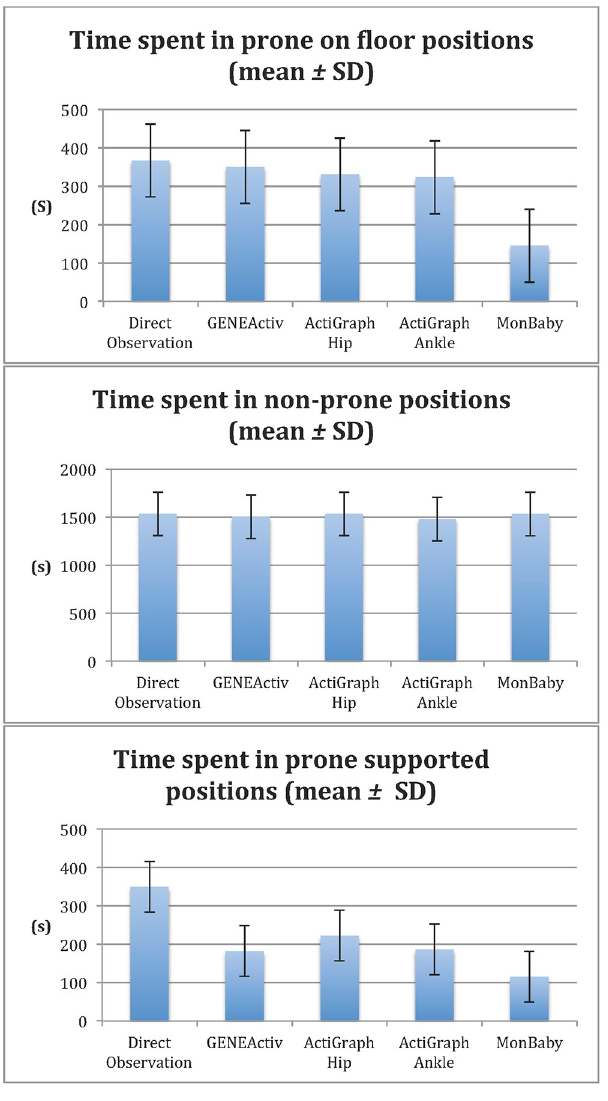
Fig 2. Time spent in prone on floor, non-prone and prone supported